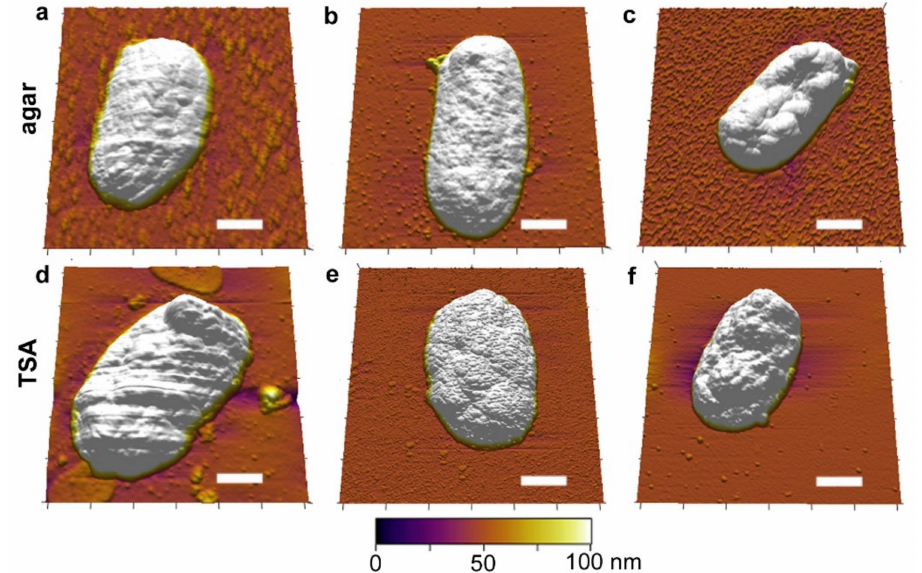
Figure 2. 3D images of Yersinia pestis cells obtained using atomic force microscopy (AFM) imaging. Cells were cultured under di ff erent conditions—top row in agar and lower row in TSA. ( a ) agar (plate), ( b ) agar (in 3D printed chamber with no soil) ( c ) agar (3D printed chamber with soil) ( d ) TSA (plate) ( e ) TSA (in 3D printed chamber with no soil) ( f ) TSA (3D printed chamber with soil). Scale bar on all images = 500 nm. Note that representative images are presented and may not correspond to the statistical data shown below, which were collected for several cells. The presence of some debris is noted on the samples cultured on the plates in both agar and TSA.